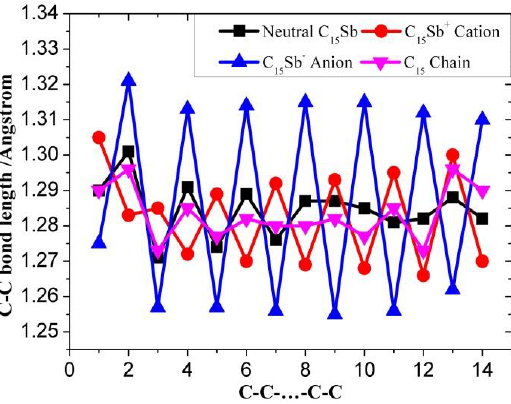
Figure 1. C-C bond length alteration of neutral C 15 Sb, C 15 Sb + cation, C 15 Sb − anion, and pure carbon chain C 15 as a function of number of carbon atoms.